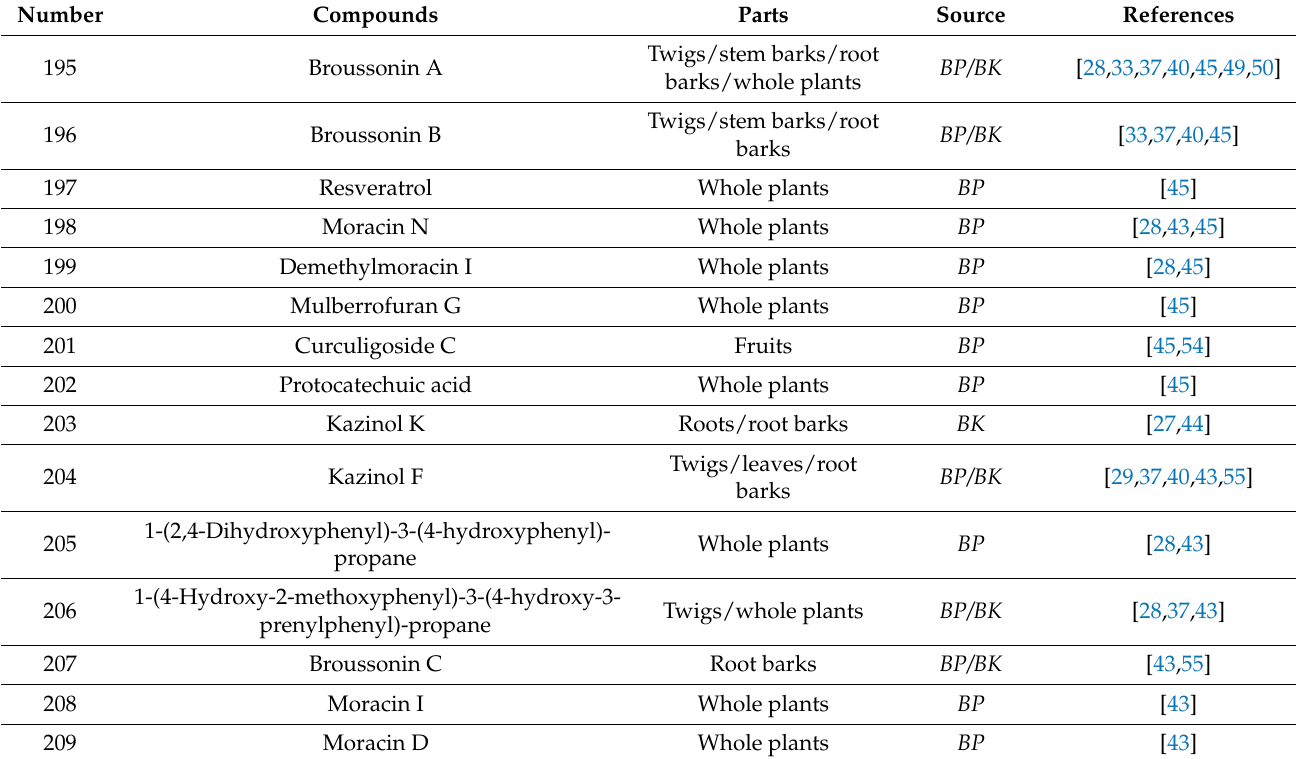
Table 3. Polyphenols isolated from Broussonetia